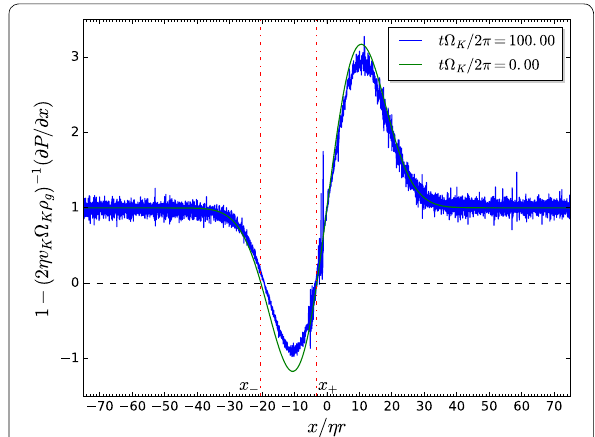
Fig. 1 Radial distribution of the normalized radial pressure gradient force f at the midplane. Initially, there are two points, x − = − 20.36 and x + = − 3.13 , where f = 0